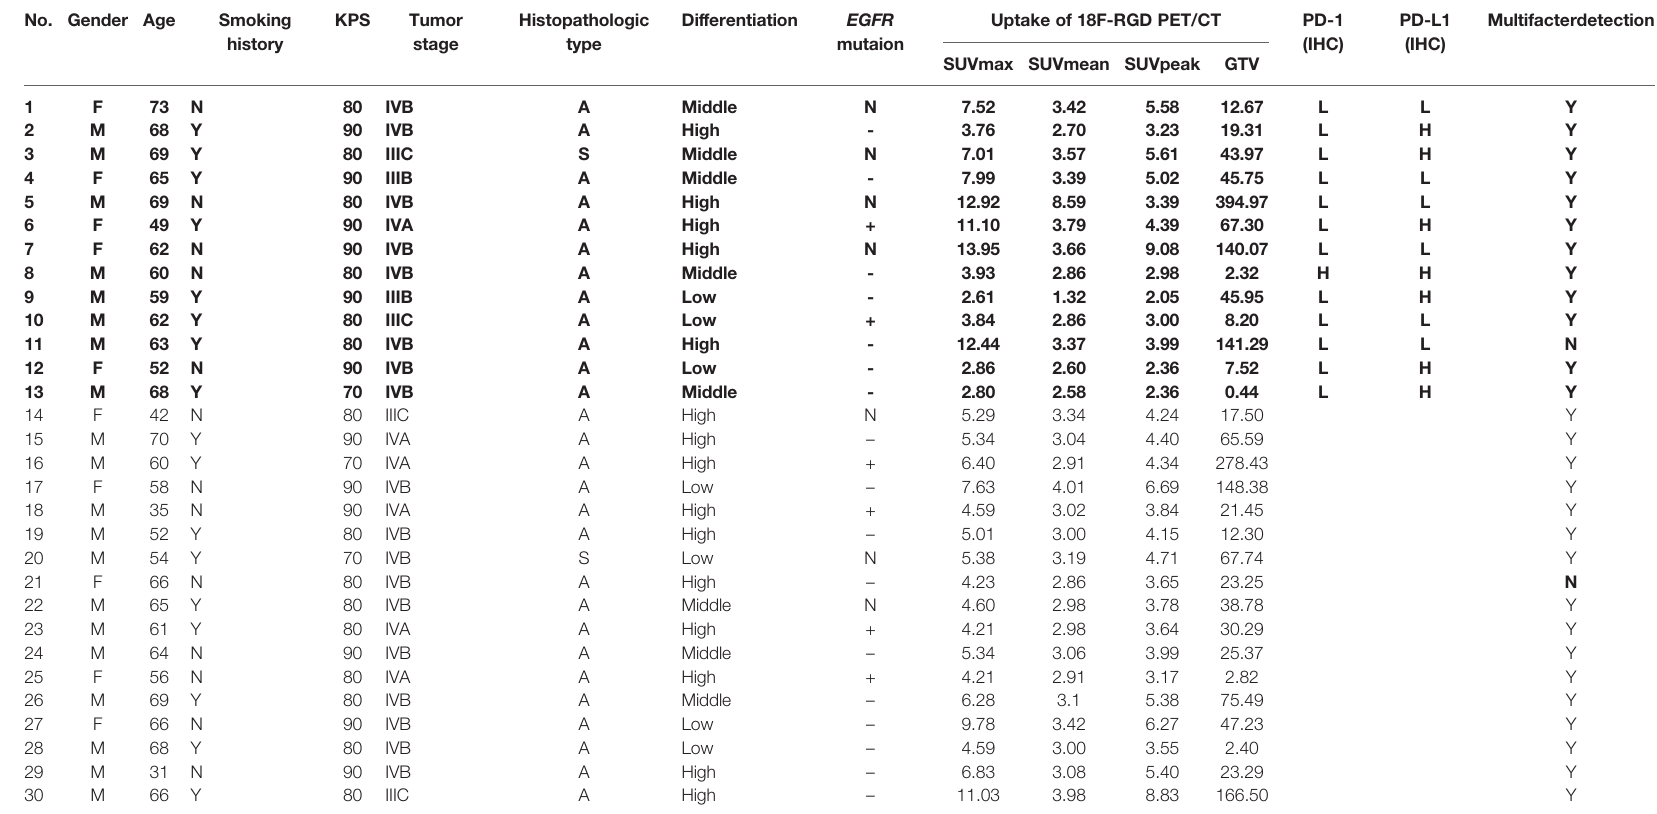
TABLE 2 | Thirteen out of the thirty patients were analyzed immunohistochemically by samples obtained from primary tumors by core needle biopsy and they are highlighted in bold. No. Gender